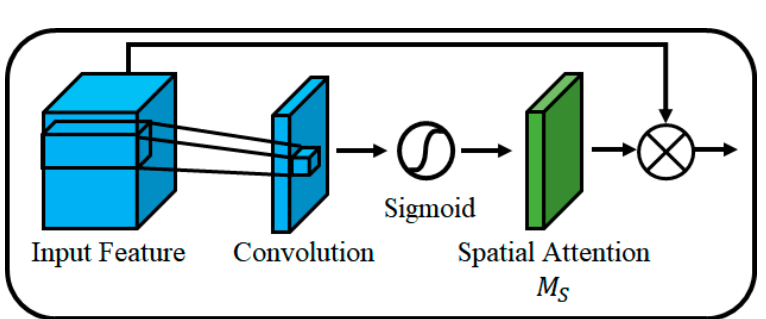
Figure 10. Spatial Attention